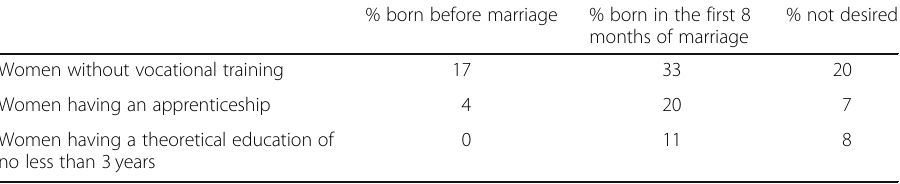
Table 14 Timing of first child, according to wife ’ s education, Denmark, 1970